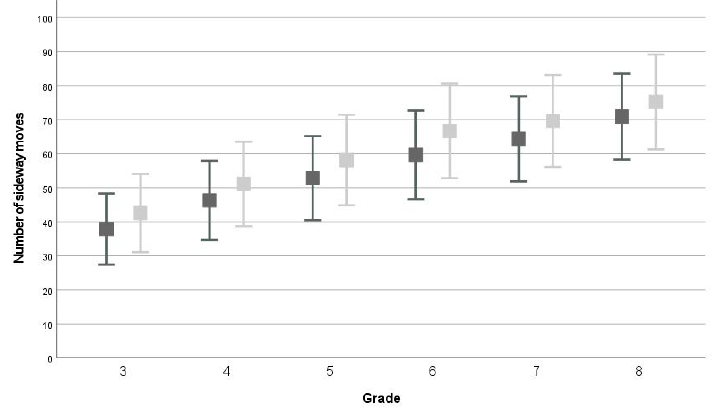
Figure 2. Average and standard deviation on jumping sideways test at T0 (dark grey) and T1 (light grey).